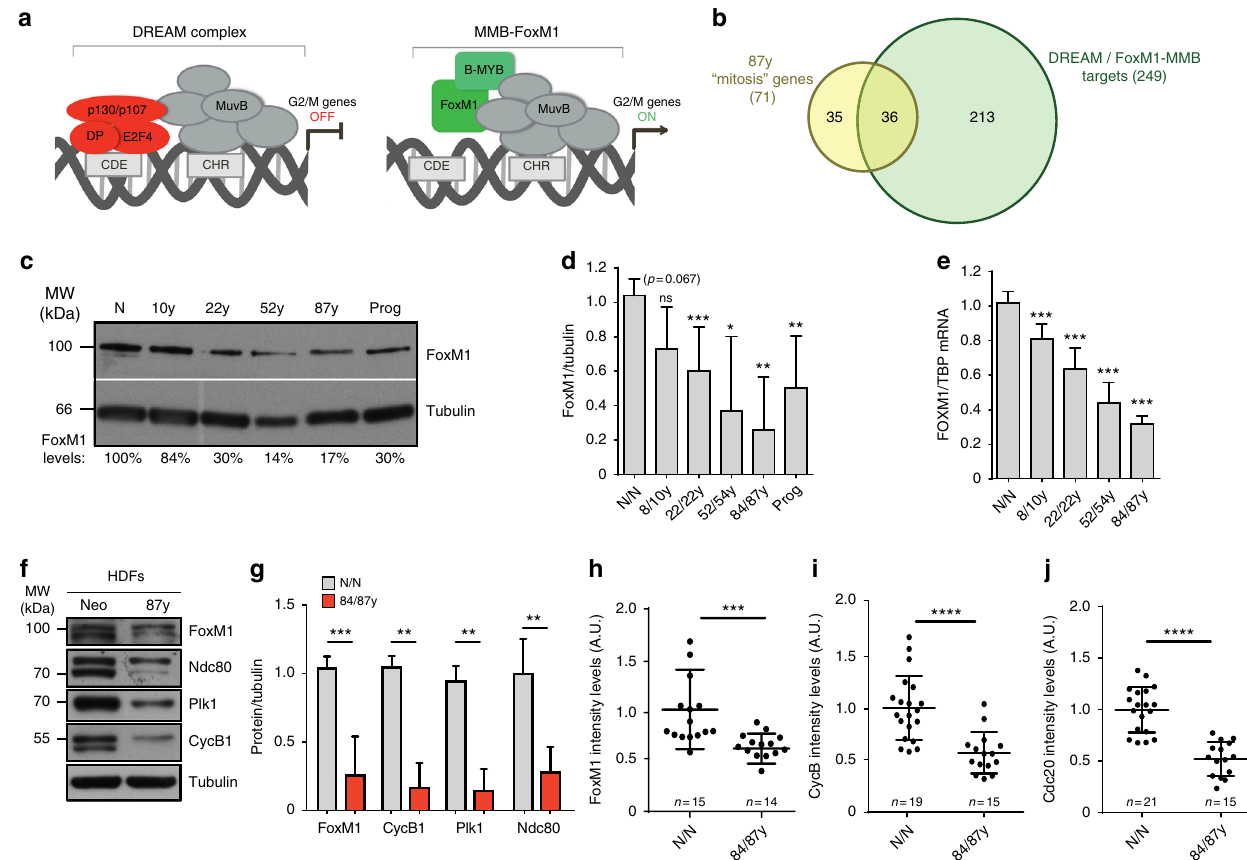
Fig. 4 Aging cells express low levels of FoxM1 and mitotic transcripts during mitosis. a Regulation of G2/M cell cycle genes by competitive binding of DREAM and FoxM1-MMB transcriptional complexes to CDE/CHR promoter elements, as described in ref. 40 . b Venn diagram displaying the overlap between mitosis genes altered in elderly fi broblasts (87 y) and targets of DREAM/FoxM1-MMB complex 40 (Supplementary Data 6). c , d FoxM1 protein levels in mitotic extracts of different age samples. FoxM1 levels were normalized to α -tubulin levels and to the neonatal sample (N/N). e FOXM1 transcript levels in mitotic total RNA from different age samples normalized to TBP transcript levels and compared to neonatal. f , g Protein levels of FoxM1 transcriptional targets in mitotic extracts of neonatal and elderly fi broblasts. Values are normalized to α -tubulin levels and to the neonatal sample (N/N). h – j Quantitative analysis of FoxM1 ( h ), Cyclin B ( i ), and Cdc20 ( j ) immuno fl uorescence intensity levels in n = single mitotic cells (N/N and 84/87 y) (Supplementary Fig. 5). Relative intensity levels are indicated as arbitrary units (A.U.). Values are mean ± SD of two ( h – j ) or three ( d , e , g )